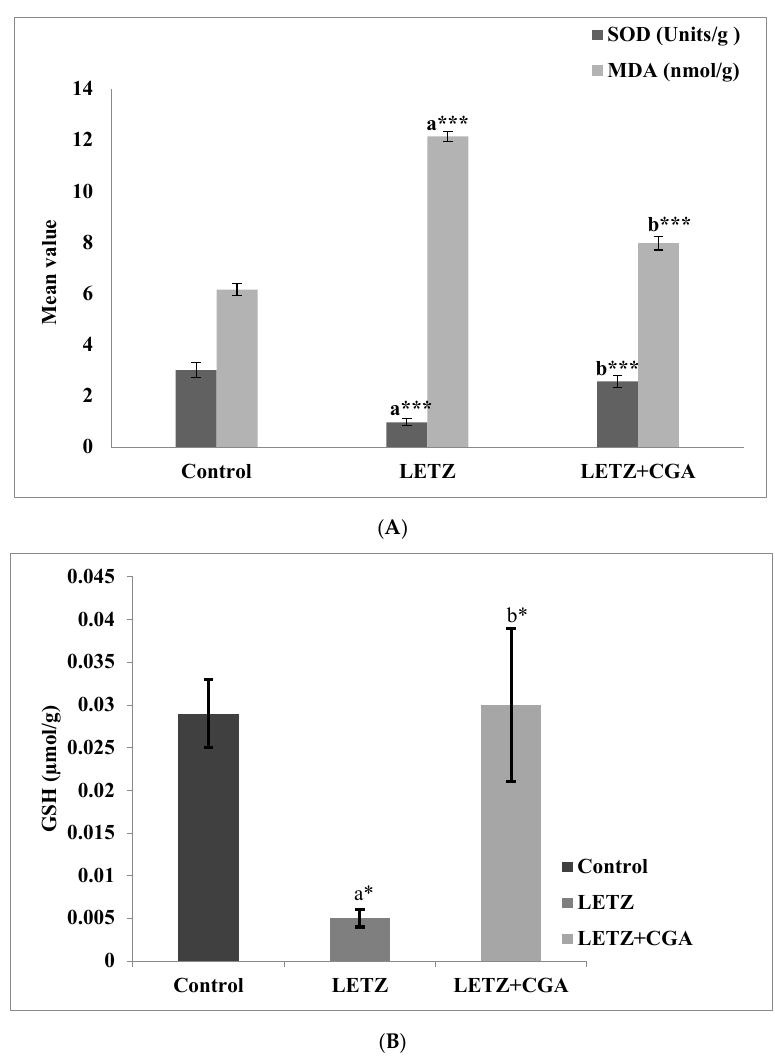
Figure 3. ( A ) Effect of CGA on MDA and SOD levels in mice with PCOS. Control: normal saline; PCOS: letrozole (6 mg/kg); PCOS with CGA: LETZ at 6 mg/kg and CGA at 50 mg/kg; a = LETZ versus control; b = LETZ versus LETZ with CGA. All values displayed are expressed as means ± SEM with 6 animals in each group. *** p < 0.001; CGA = chlorogenic acid; LETZ = letrozole. ( B ) Effect of CGA on GSH levels in mice with PCOS. Control: normal saline; PCOS: letrozole (6 mg/kg); PCOS with CGA: LETZ at 6 mg/kg and CGA at 50 mg/kg; a = LETZ versus control; b = LETZ versus LETZ with CGA. With n = 6 per group, all values are expressed as means with standard errors. * p < 0.05; CGA = chlorogenic acid; LETZ = letrozole.